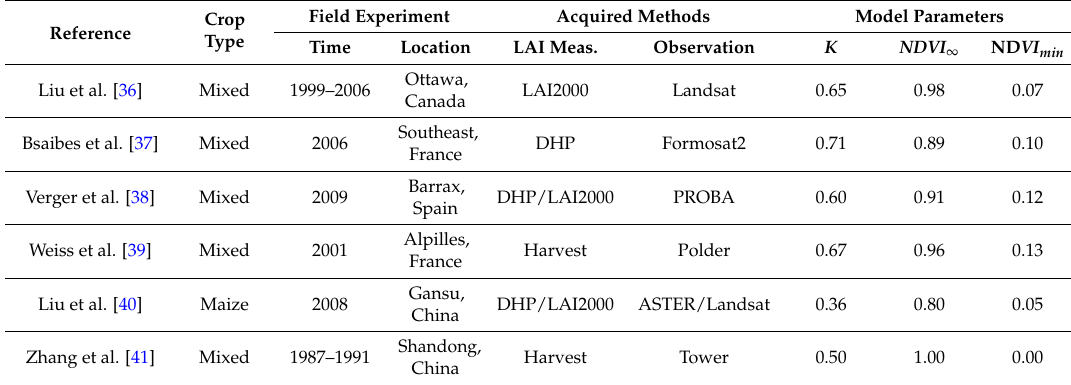
Table 2. A priori knowledge base for crops consisting of six published